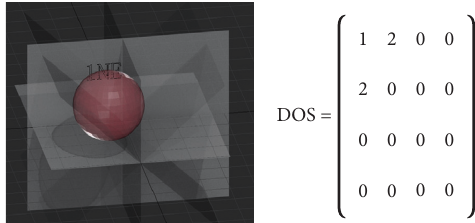
Figure 8: Examples of “weakly presence”.